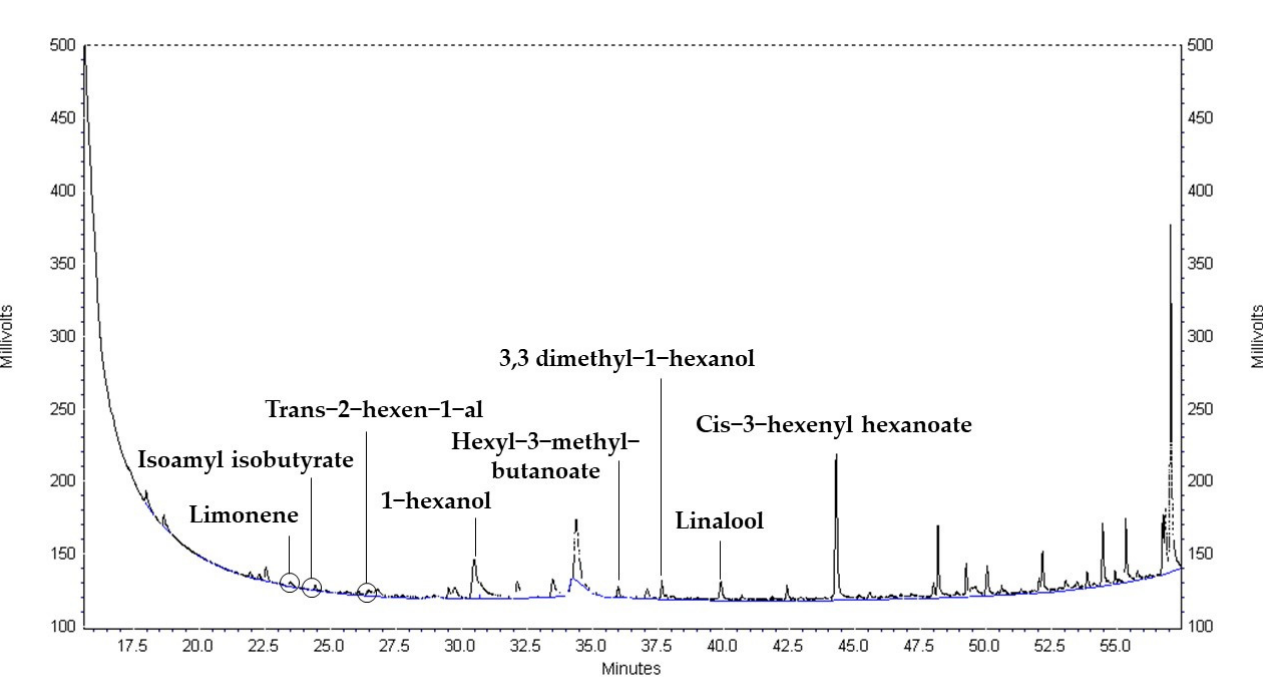
Figure A1. Chromatogram of the standards.